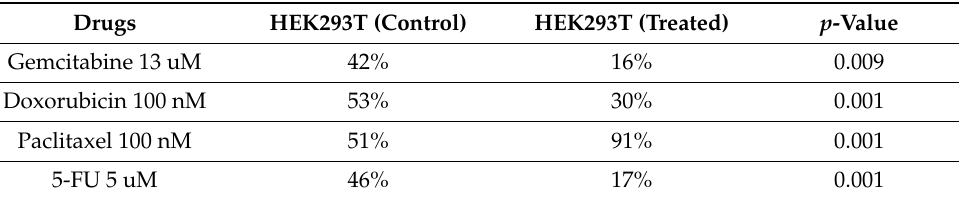
Table 1. The MTT assay results for cell lines treated with chemotherapeutics expressed as average percentage of cell viability. HEK293T (control): previously treated with serum of healthy volunteers. HEK293T (treated): previously treated with serum of PDAC patients. Drugs HEK293T (Control) HEK293T (Treated) p -Value Gemcitabine 13